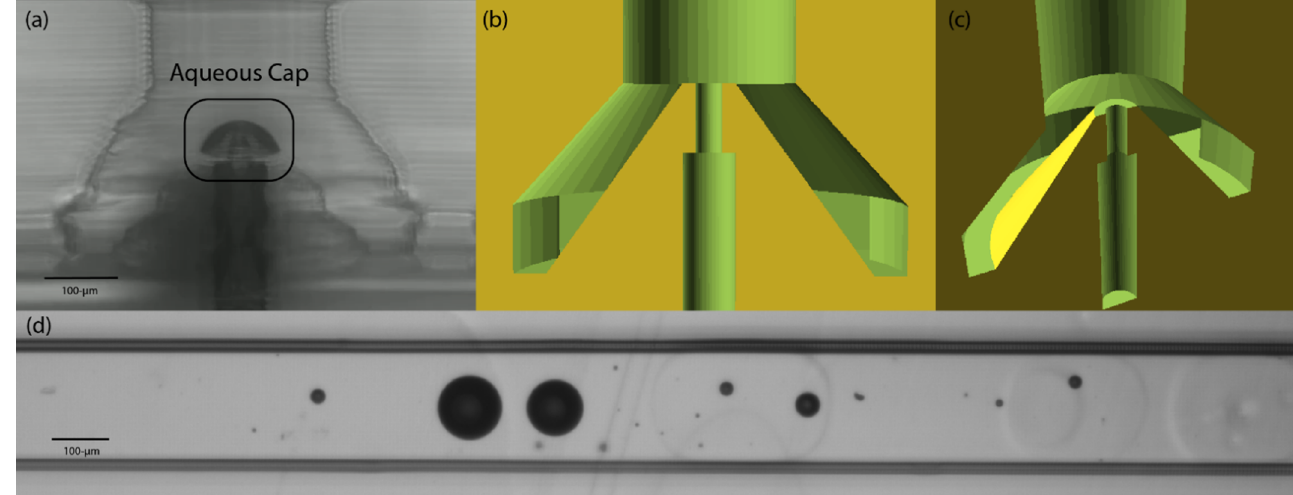
Figure 1. Droplet-on-demand generator printed from PEG-diacrylate monomer. ( a ) Microphotograph of the pedestal of the droplet generator showing the darker aqueous phase spreading over the top of the cone-shaped pedestal. Oil flows up from the outside of the cone, and the aqueous phase flows up the channel in the central core of the cone. ( b ) Schematic showing a side view of the polymerized polymer (in yellow) and the open channels in green forming the cone and pedestal. ( c ) Schematic showing an upward-looking view of the pedestal, which is the light green disk at the top of the darker ‐ green cone. ( d ) Example of droplets and satellites formed when the upper surface of the pedestal is wetted with the aqueous phase.